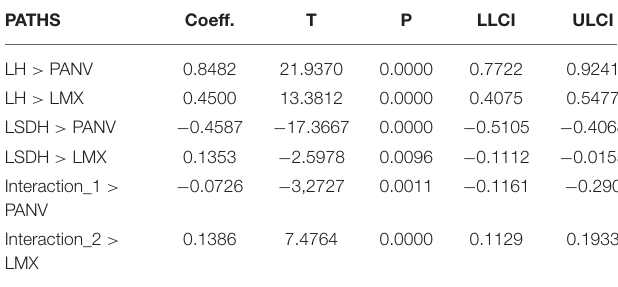
TABLE 3 | Structural model summarized (direct effects).